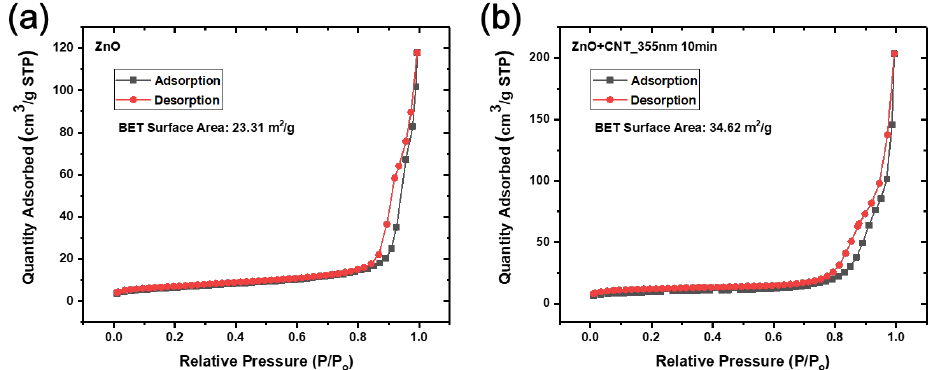
Figure 5. N 2 adsorption–desorption isotherm for measuring Brunauer–Emmett–Teller surface areas of ( a ) ZnO NS and ( b ) ZnO NS-CNT (355 nm, 10 min), respectively. Black and red lines represent adsorption and desorption data, respectively.